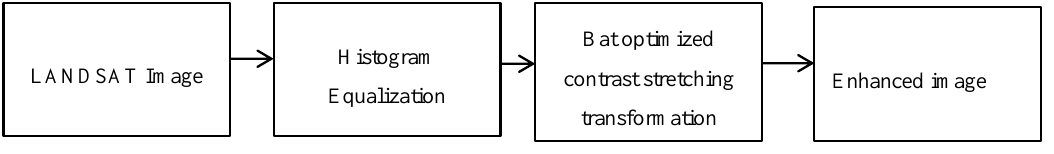
Figure 1. Contrast enhancement framework.